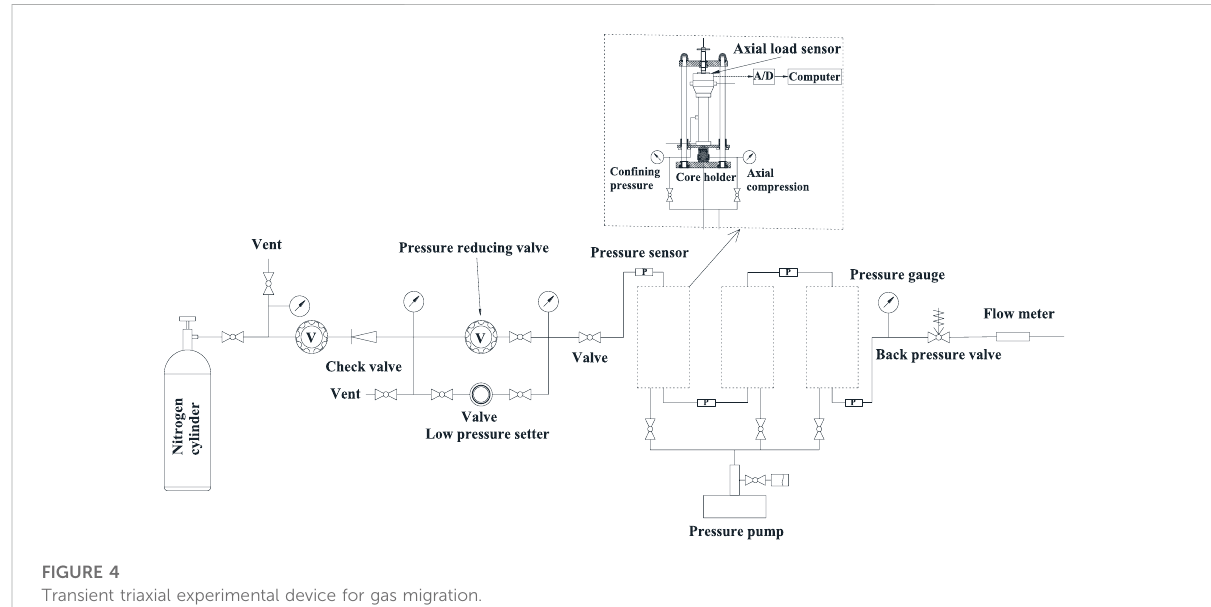
FIGURE 4 Transient triaxial experimental device for gas